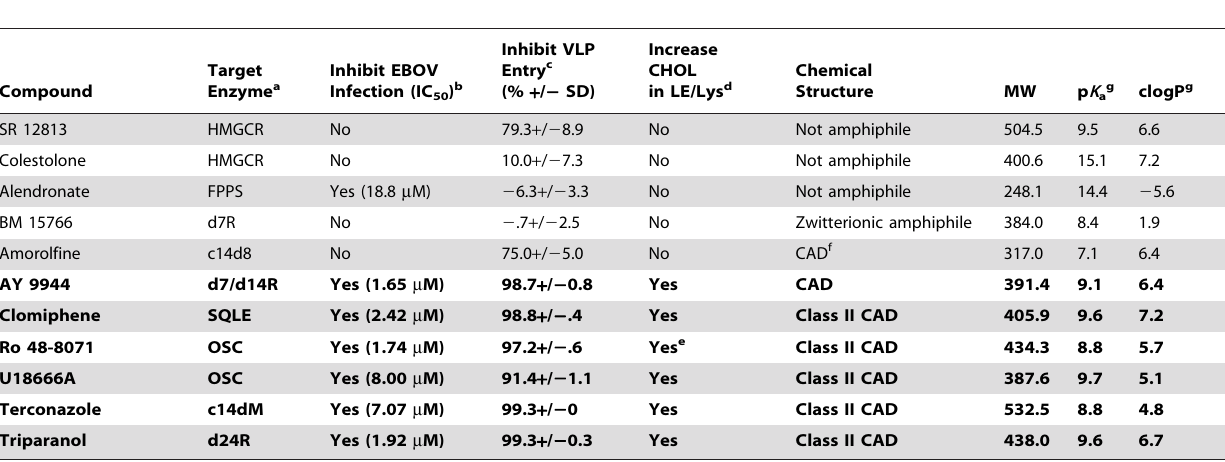
a abbreviations of target enzymes in cholesterol synthesis pathway: HMGCR, HMG CoA Reductase; FPPS, Farnesyl pyrophosphate synthase; d7R, Sterol delta-7 reductase; c14d8, Lanosterol C14-demethylase/sterol delta; d7/d14R, Sterol delta-7 and delta-14 reductase; SQLE, Squalene epoxidase; OSC, 2,3 Oxidosqualene cyclase; c14dM, Lanosterol C14-demethylase; d24R, Sterol delta-24 reductase. b data for clomiphene are from Johansen et al., in revision; all other data are from Fig. 1. c data from Fig. 2. d data from Fig. 5; CHOL, cholesterol.